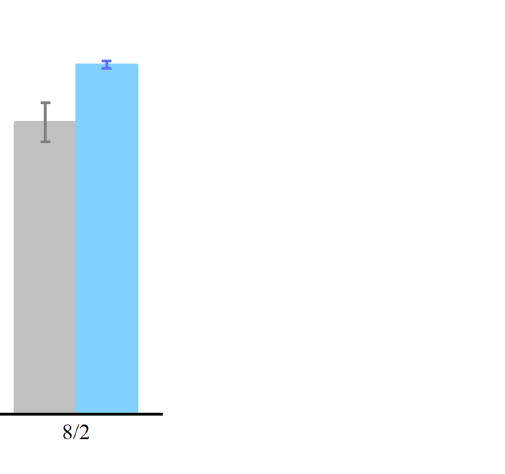
Figure 13. The bending modulus of the WF/PP